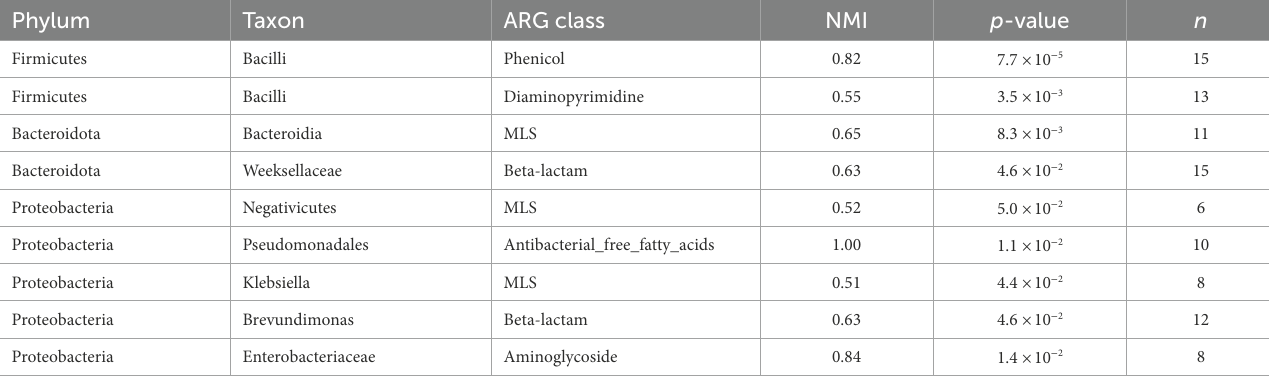
TABLE 3 Normalized mutual information (NMI) value and chi-squared p -value based on the presence of ARGs within each ARG class within the different taxons starred in Figure 4.